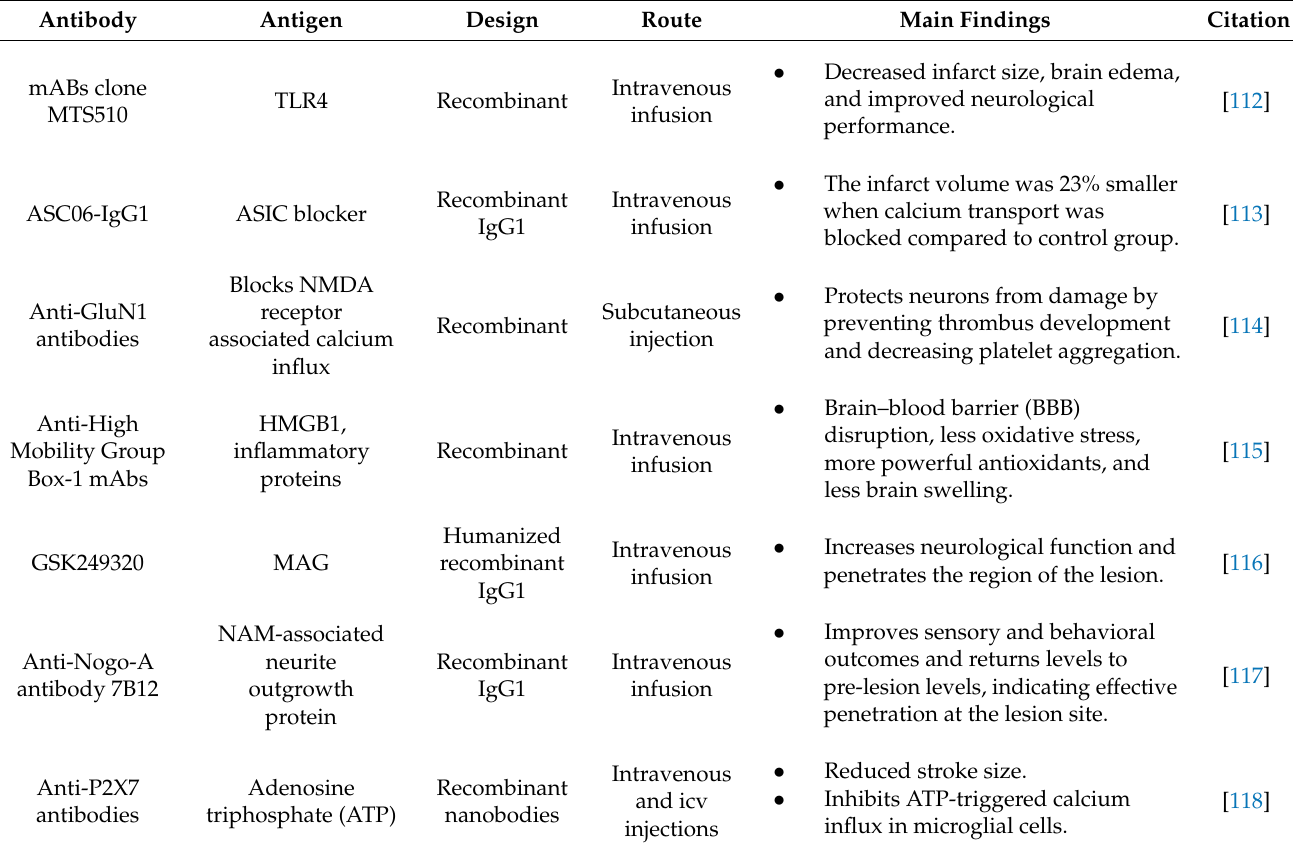
Table 2. Evaluation of mAbs in animal models of cerebral